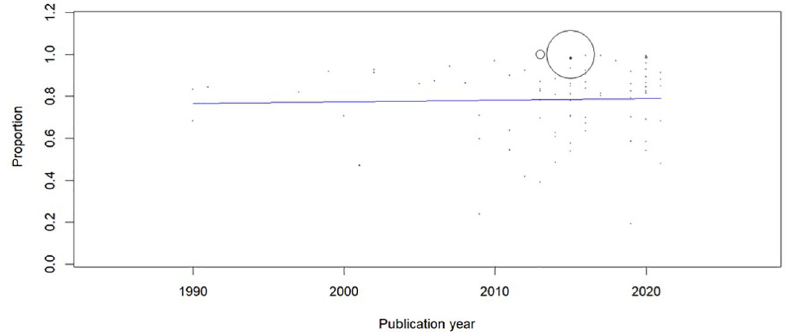
Figure 4. Meta-regression to evaluate the trends in the prevalence of musculoskeletal disorders (MSD).